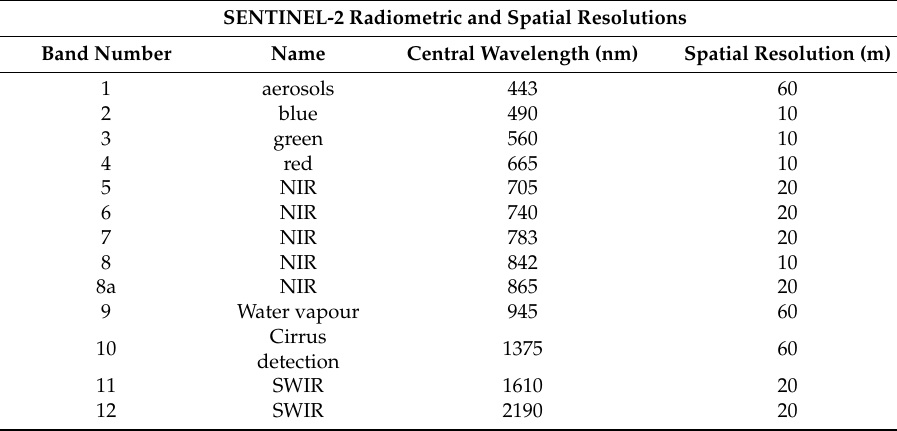
Table 1. Radiometric and spatial resolution of Sentinel